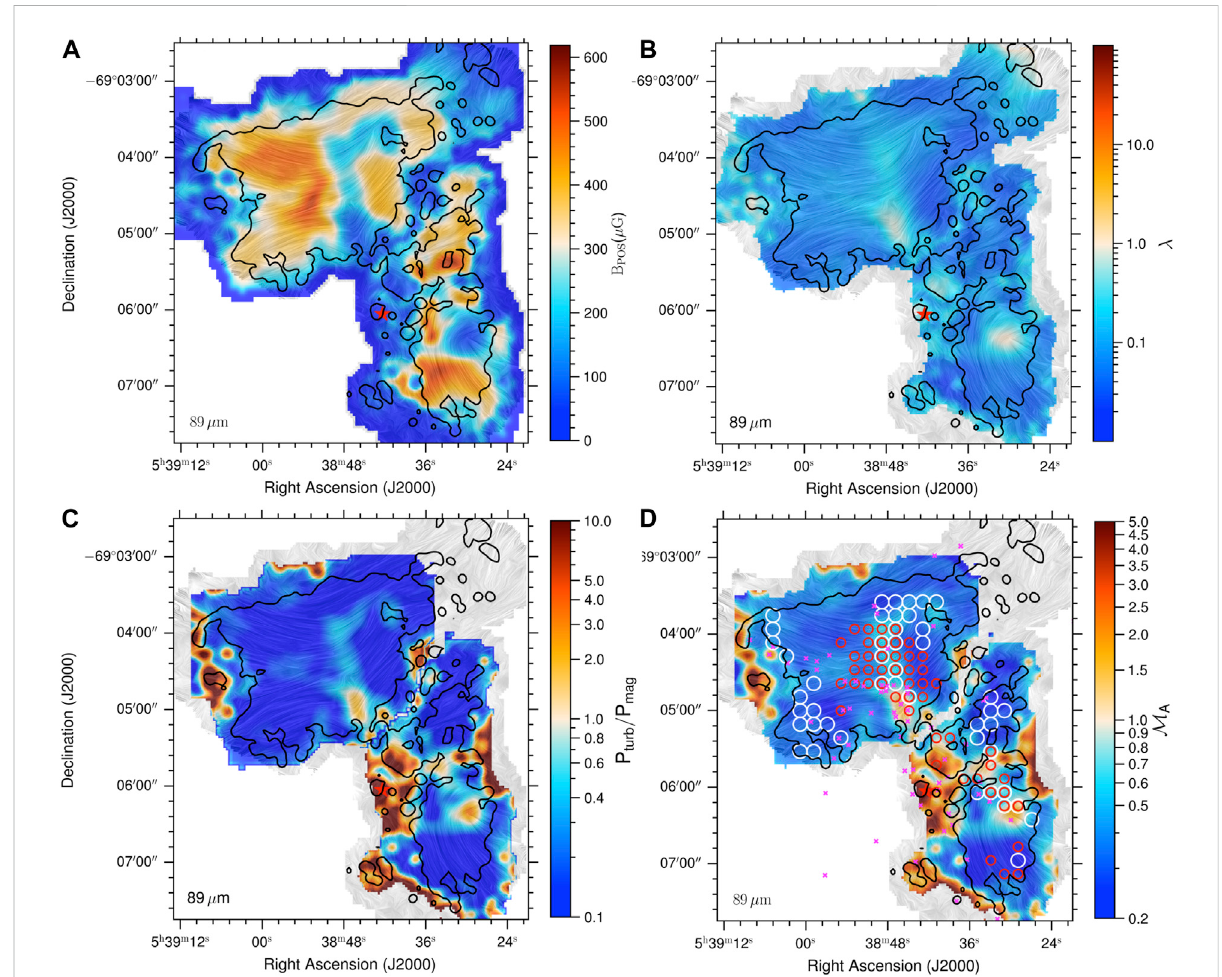
FIGURE 14 Maps of magnetic strength (A) , of mass-to- fl ux ratio (B) , of turbulence-to-magnetic pressure (C) , and of Alfvénic Mach number (D) in 30 Dor ( fi gure adopted from Tram et al., 2022). Stream lines are the magnetic fi eld morphology inferred from thermal dust polarization. Star symbol locates themassivestellarclusterR136.Blackcontoursenclosetheareawherewetrustthedata.Circlesindicatewherethegasvelocitygradientparallelsto the fi eld lines (red for CII and white for CO), whereas gas velocity gradient perpendiculars to the fi eld lines. Magenta crosses are the YSOs